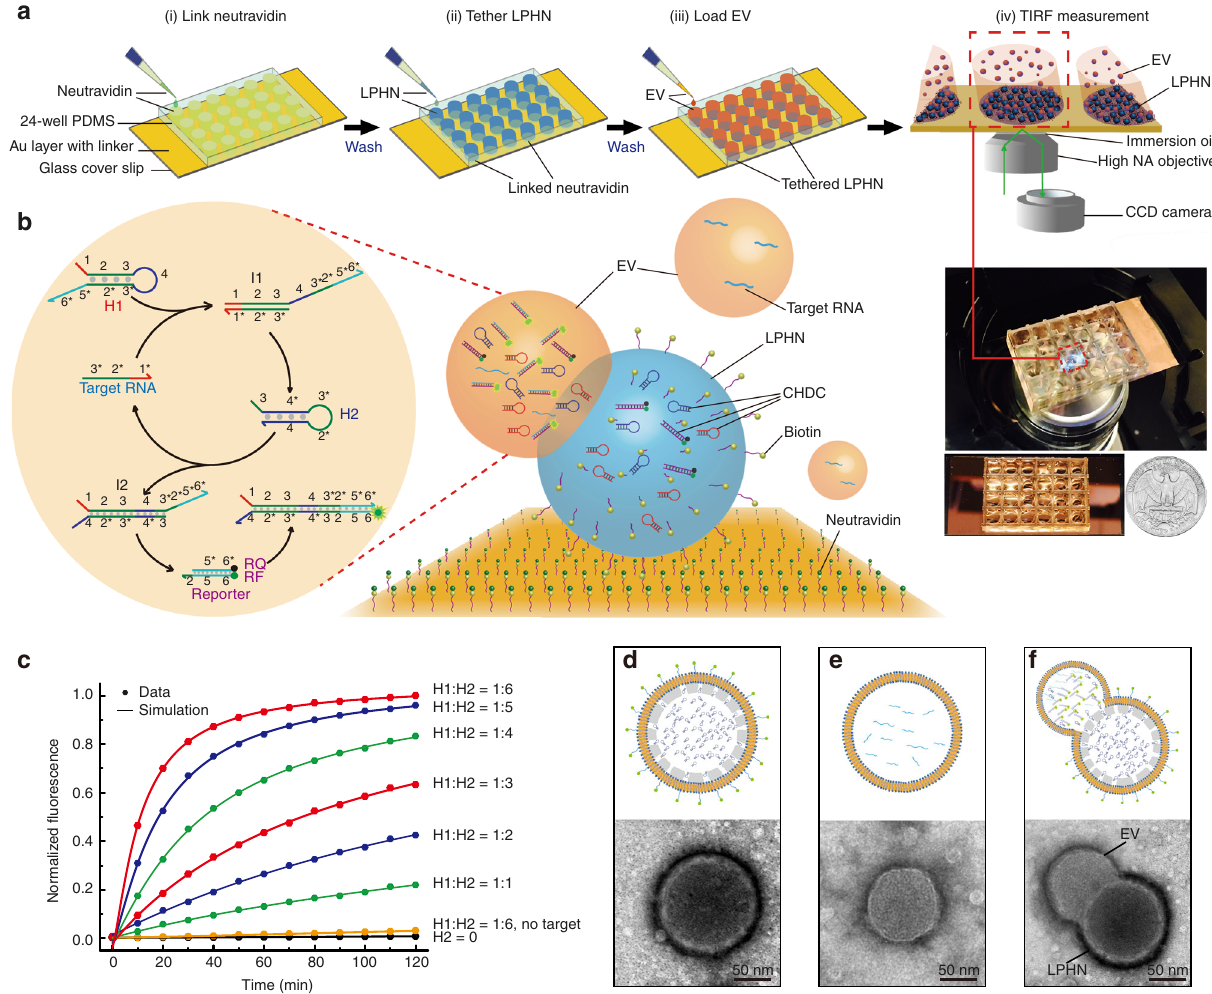
Fig. 1 Principle and characterization of LPHN – CHDC biochip. a Stepwise operation of LPHN – TIRF assay, which is composed of link neutravidin (i), tether lipid-polymer hybrid nanoparticle (LPHN) (ii), load extracellular vesicle (EV) (iii), and TIRF measurement (iv). b Schematic illustration of catalyzed hairpin DNA circuit (CHDC) consisting of H1, H2, and reporter for signal ampli fi cation of target RNA in LPHN – EV complex (right). One target RNA catalyzes the hybridization of H1 and H2 through toehold-mediated strand displacement reactions for multiple cycles, which further destabilizes reporter moiety and generates ampli fi ed fl uorescence (left). c Demonstration of catalysis. Different molar ratios of H1 – H2 were introduced into CHDC at t = 0. H1 = reporter = 80 pmol. 0.0 is the background fl uorescence of the absence of H2 and 1.0 is the fl uorescence of H1:H2 = 1:6 at t = 120 min. The control traces (black and yellow) show the reaction with no H2 and no target GPC1-DNA, respectively. d – f Schematic drawings and transmission electron microscopy (TEM) images of LPHN ( d ) pancreatic cancer-derived EV ( e ), and LPHN – EV complex ( f